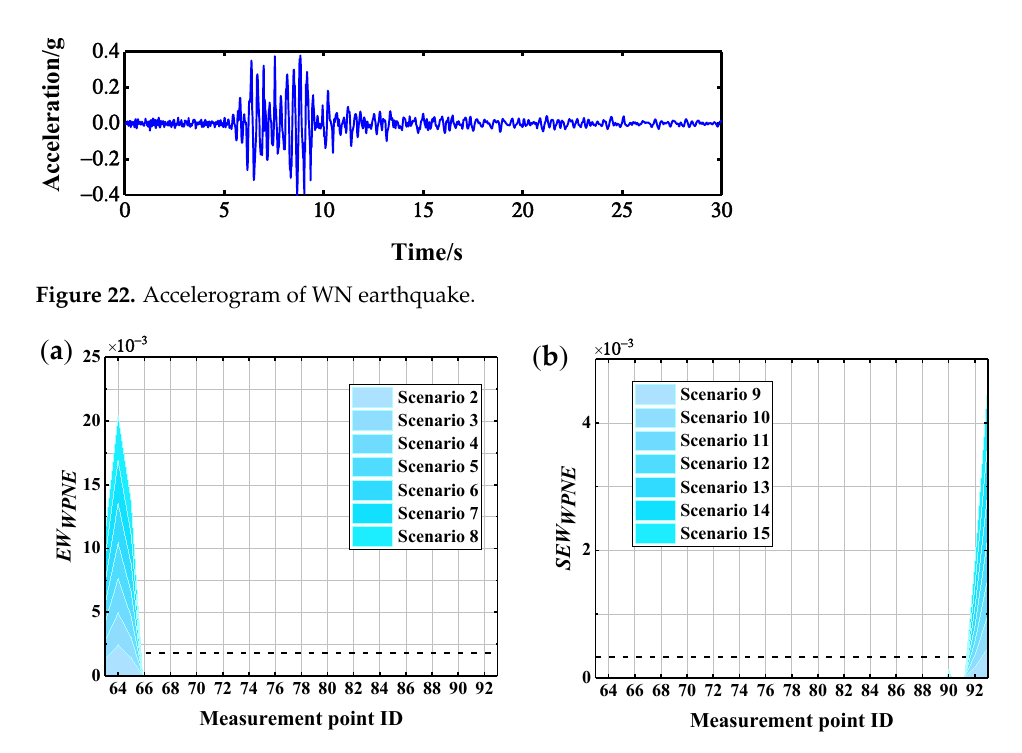
Figure 23. Damage identification results of the CCRFB under WN seismic excitation: ( a ) EW WPNE ; ( b ) SEW WPNE .